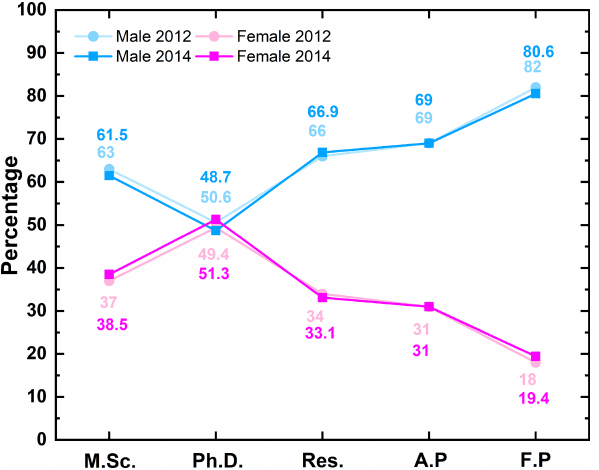
Figure 1. Proportion (%) of male and female in a typical academic career in a two time-windows: 2012 and 2014. Scissor graph show- ing the percentages of female and male MSc graduate (data source: Alma Laurea, 2019, https://www.almalaurea.it/, last access: 31 Oc- tober 2019) and PhD (data source: ISTAT, 2019, https://www.istat. it/, last access: 31 October 2019) students in geosciences as well as the proportion of women and men in the Italian academic staff (data source: MIUR, 2019, https://cercauniversita.cineca.it/php5/docenti/ cerca.php, last access: 31 October